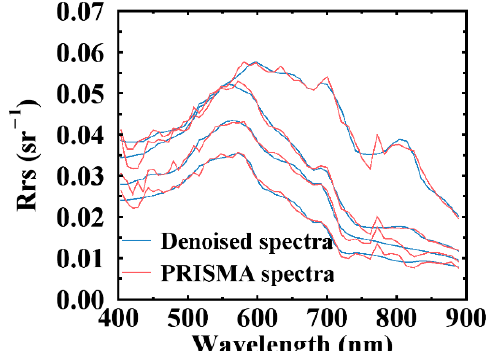
Figure 8. Typical PRISMA and their denoised spectra.